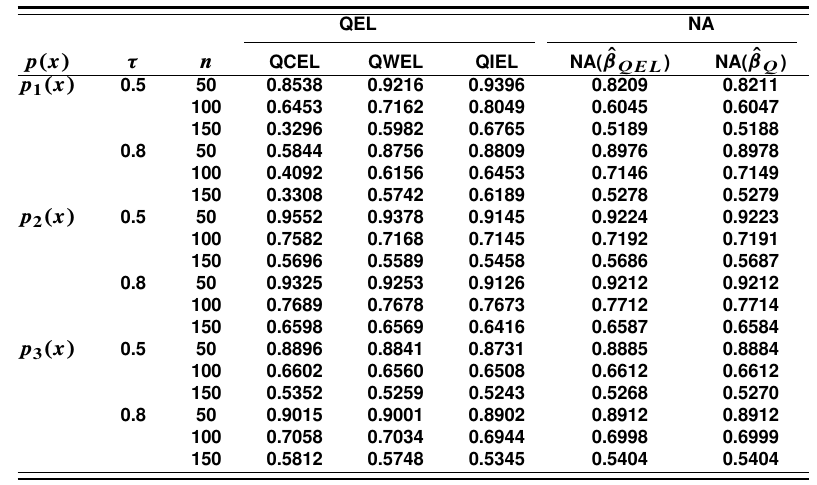
Table 3. Average lengths of the confidence intervals for ˇ in Model 2 for different forms of the selection probability function p.x/ and different values of sample size n and the quantile level (cid:28) under the nominal level 0:95 .